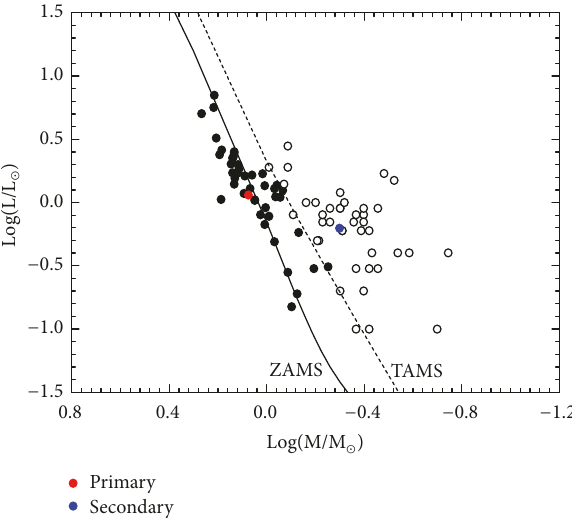
Figure 7: The mass-luminosity diagram for MT Cas. The filled and open circles represent the primary and secondary components for the W-type LTCBs [3].